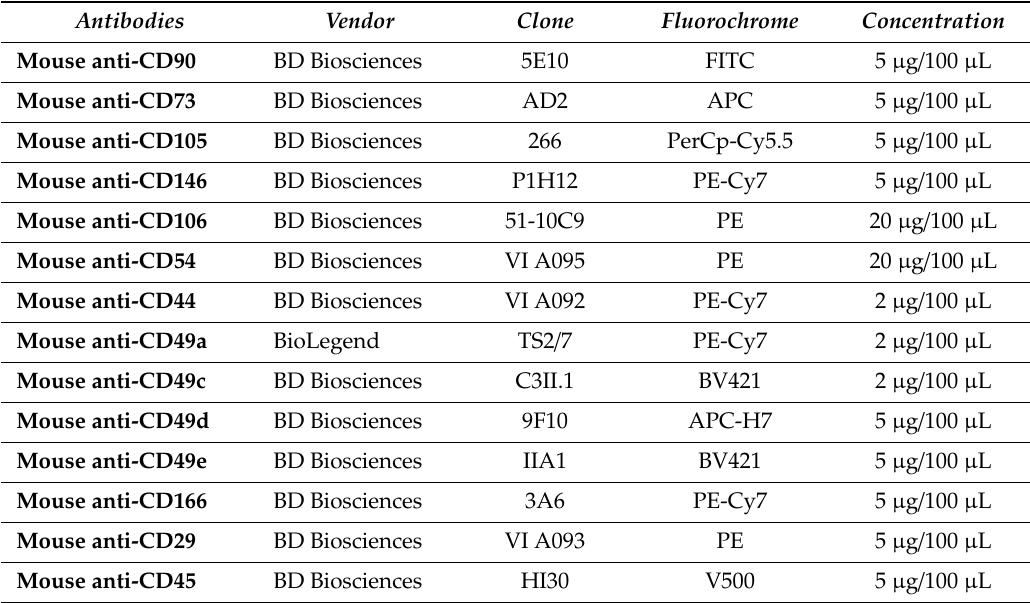
Table 2. List of antibodies for bone marrow stromal cells (BMSC) discrimination and immunophenotype characterisation by flow